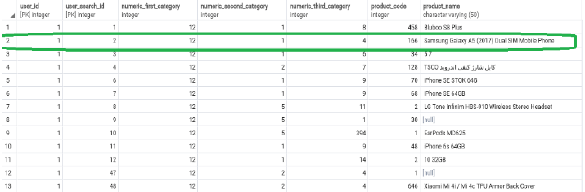
Figure 2(c) The User Searches table in the database